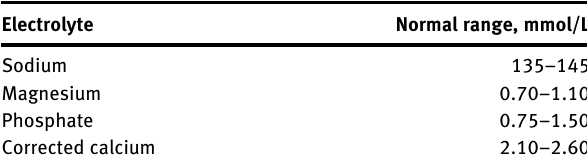
Table  : Normal electrolyte ranges.